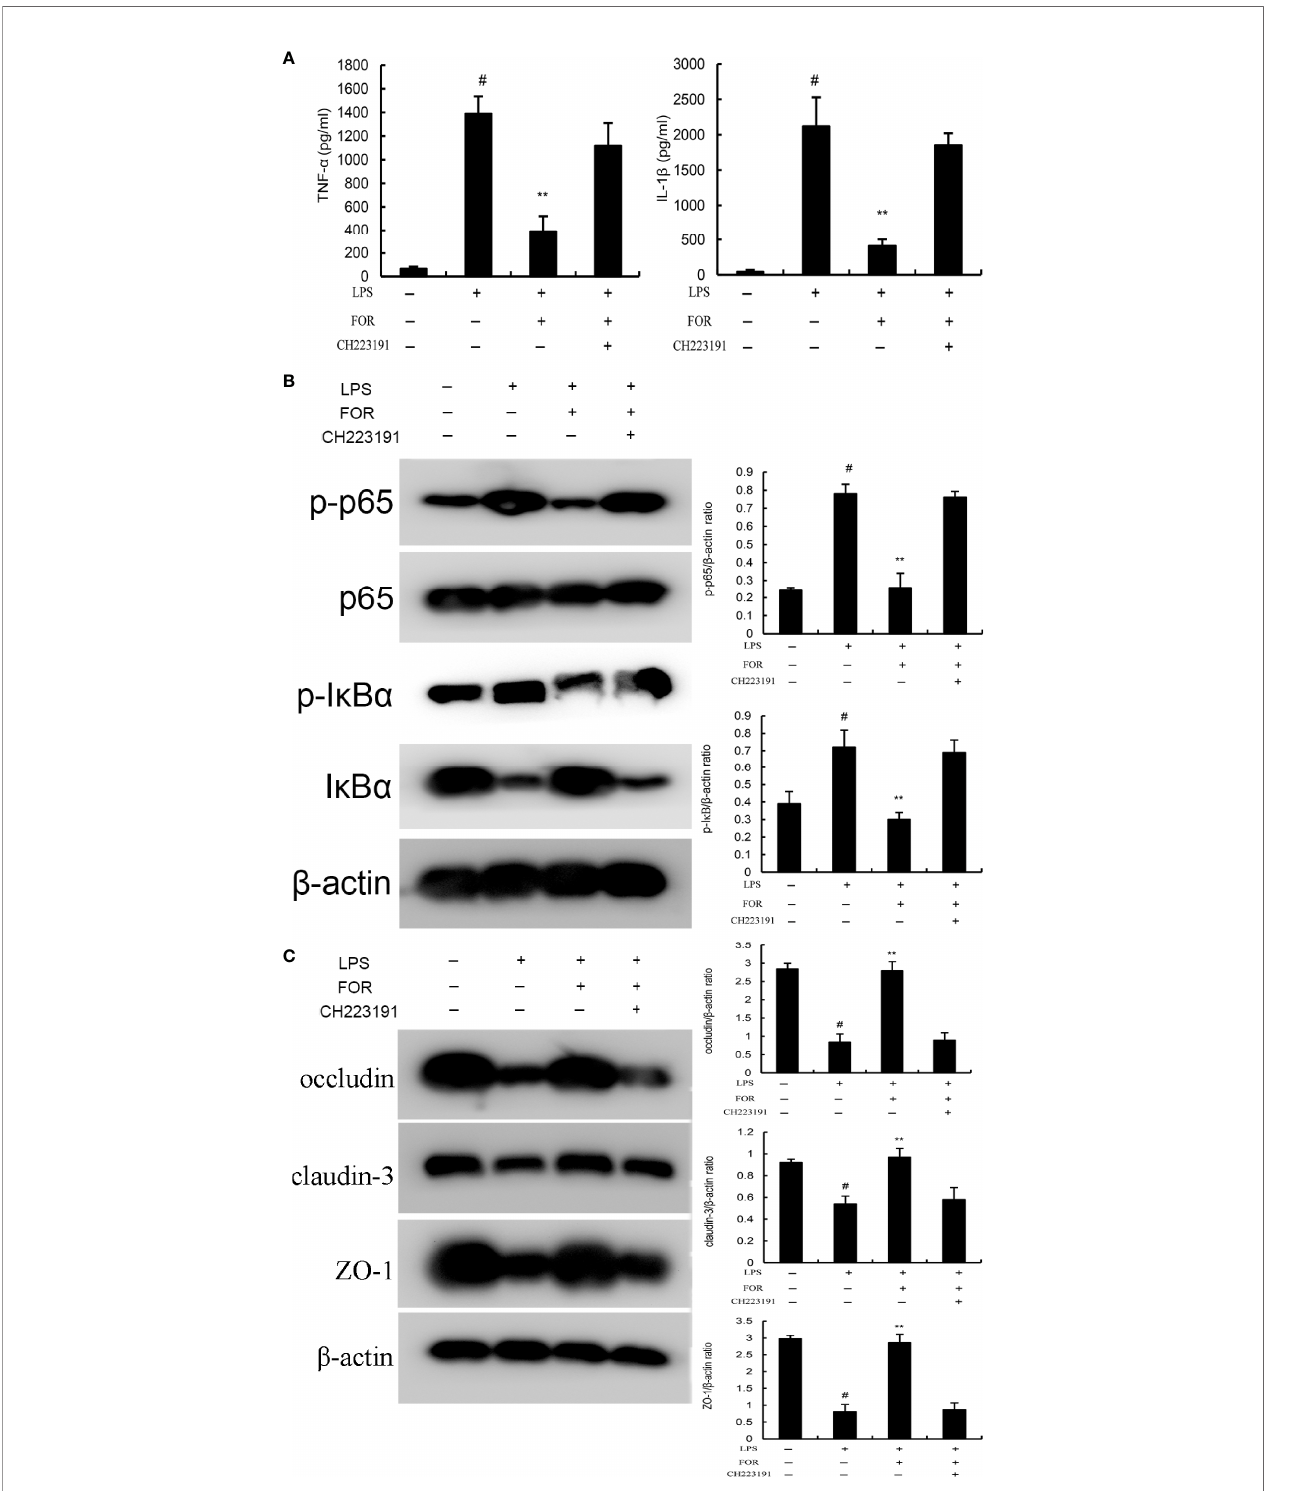
FIGURE 9 | FOR inhibits LPS-induced in fl ammation via AhR-induced Src inactivation. (A) The levels of proin fl ammatory cytokines TNF- a and IL-1 b in EpH4-Evs cells. (B) The expression of NF- k B signaling pathway. (C) The expression of tight junction proteins occludin, claudin-3, and ZO-1 in EpH4-Evs cells. The present results are displayed as the mean ± SEM of triple parallel measurements. # (P < 0.01) is signi fi cantly different from control group; **(P < 0.01) is signi fi cantly different from LPS